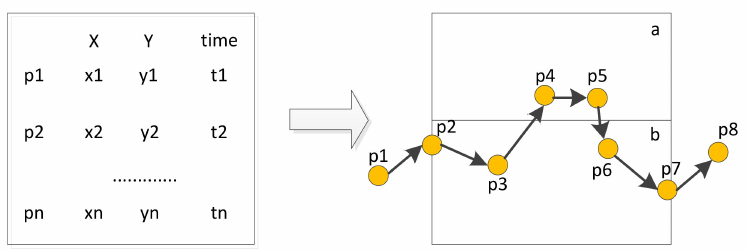
Figure 3. ( a ) Trajectory list display; ( b ) trajectory spatial